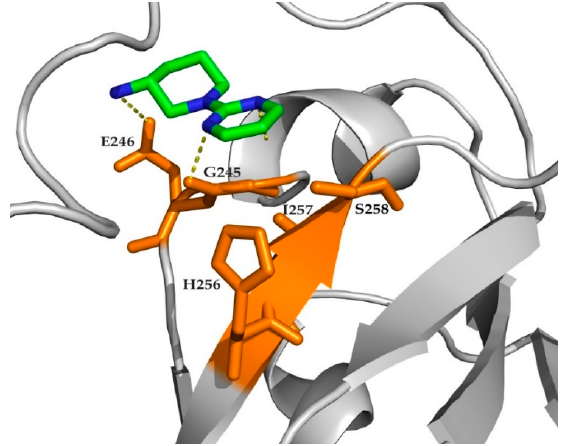
Figure 6. The representative docking model of hit 1 in consistency with experimental CSP and STD restraints. Hit 1 (green color) in the binding site of tandem RRM (PDB: 4bs2) where the carbonyl hydrogen is oriented toward G245, while the side chain hydrogen interacts with E246 residue of tandem RRM. Other active residues (orange sticks), H256, I257, and S258 are located in proximal of the hit